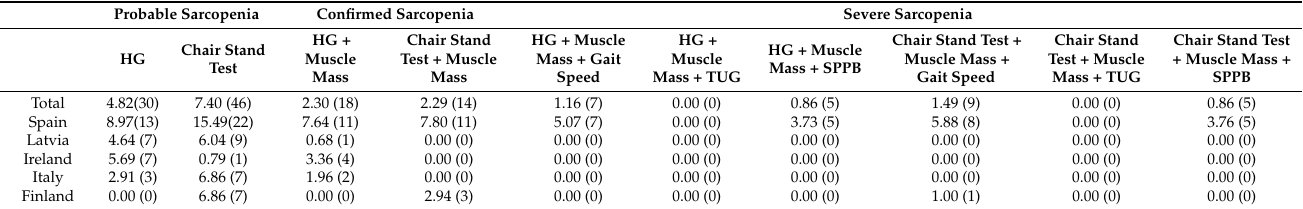
Table 2. Probable sarcopenia, confirmed sarcopenia, and severe sarcopenia of the total of the sample and for countries [%( n )]. Probable